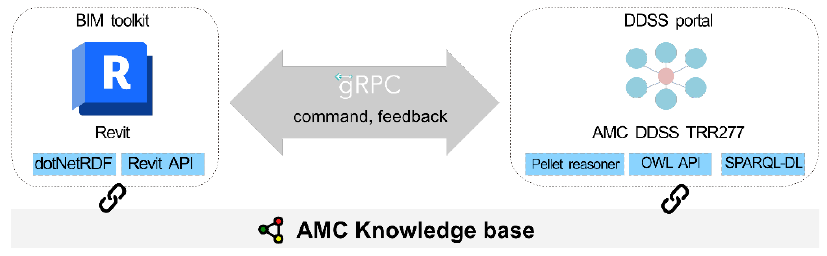
Figure 11. Technical framework for the knowledge-driven DDSS (redrawn from [42]).